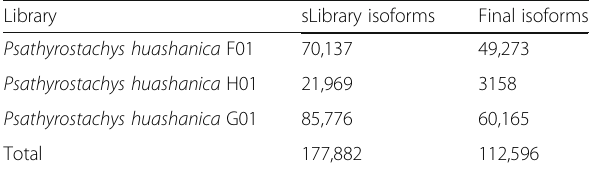
Table 2 Summary of the number of isoforms, high-quality sequences from sLibrary were clusted and corrected to